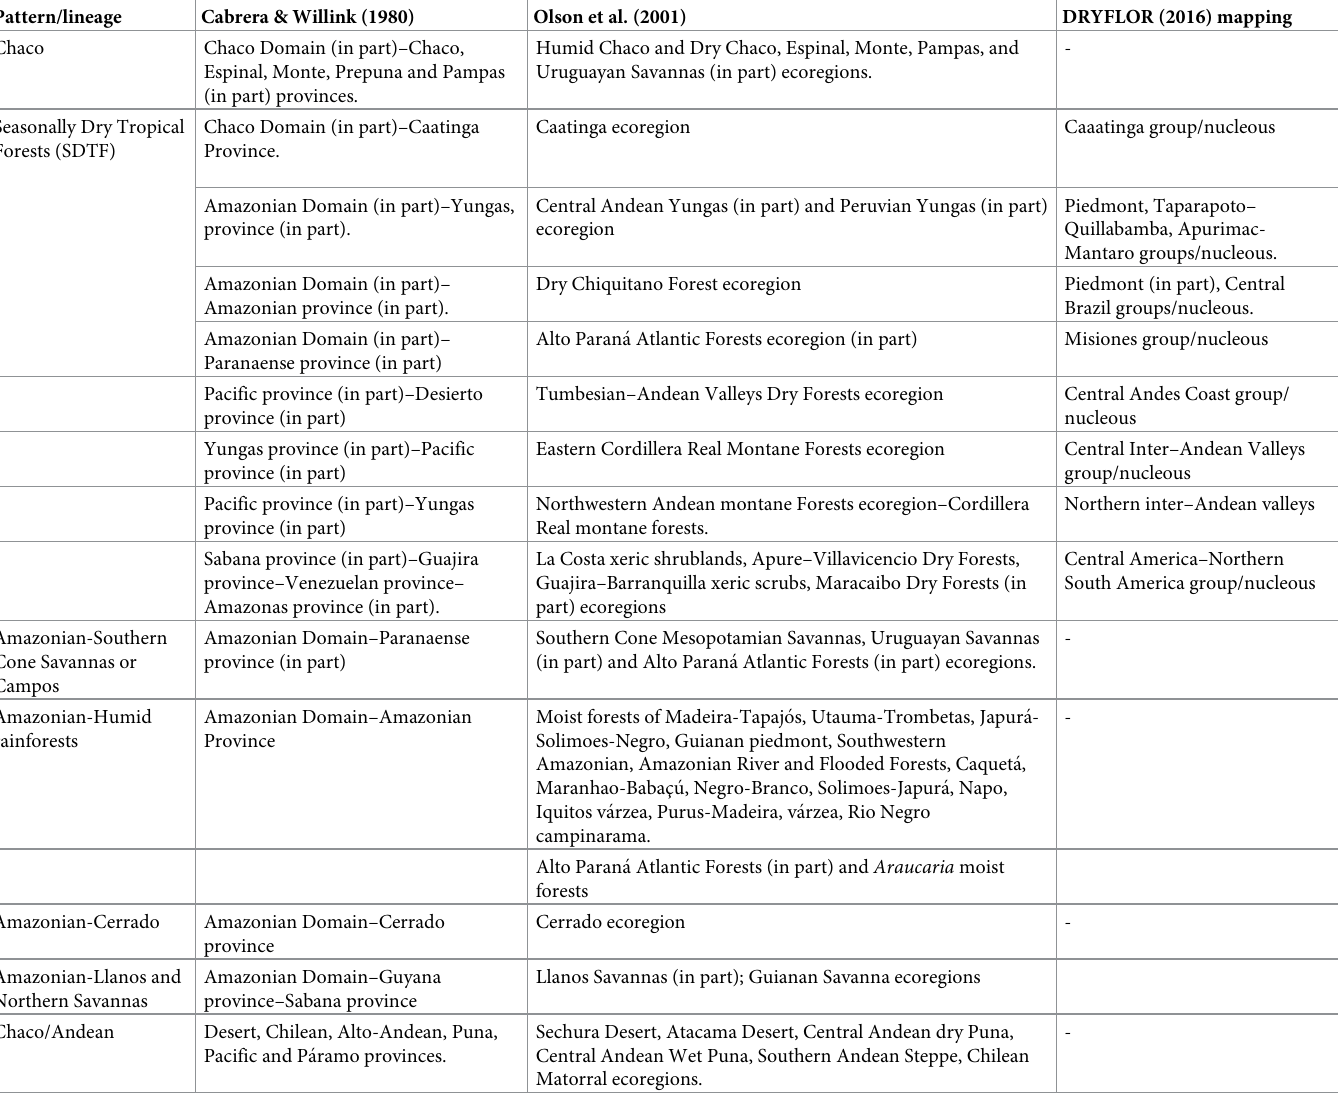
Table 2. Lineages/Distribution patterns comparison with other biographical divisions and ecoregions for the Gran Chaco and adjacent areas.